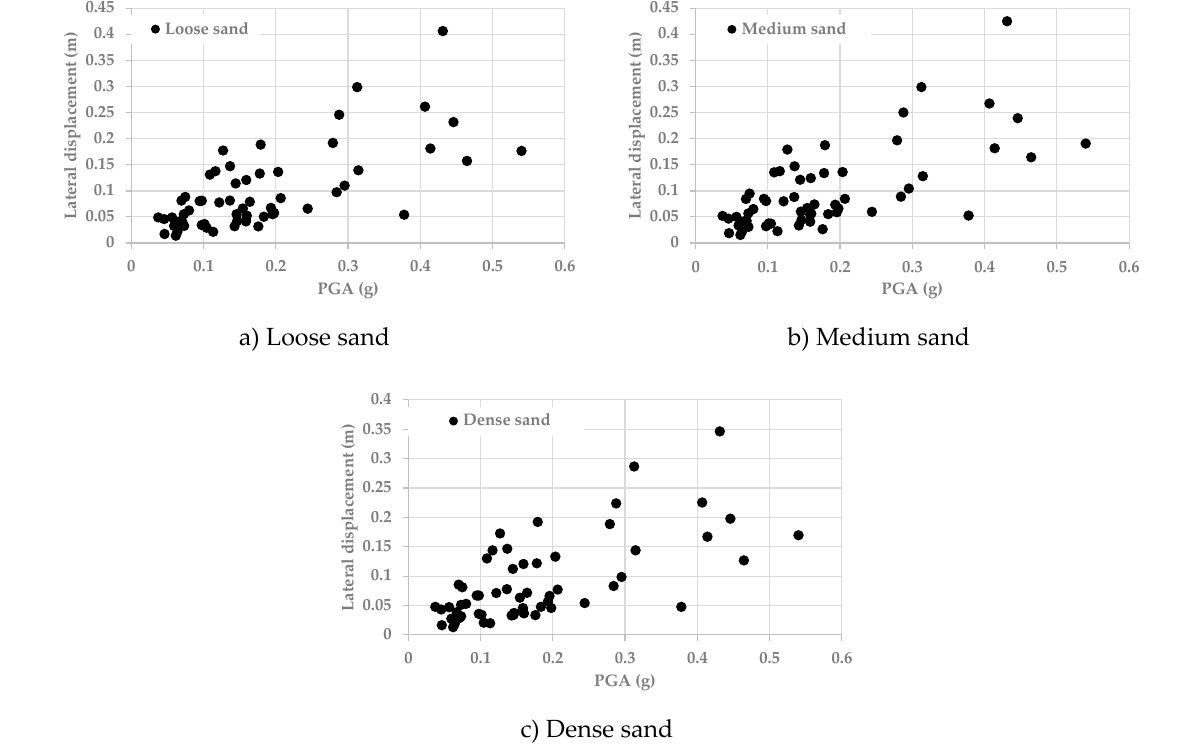
Figure 8. Effect of the thickness of the liquefiable layer on the lateral displacement of the building- time history for the case of a building resting on medium sand and subjected to LOS earthquake shake.